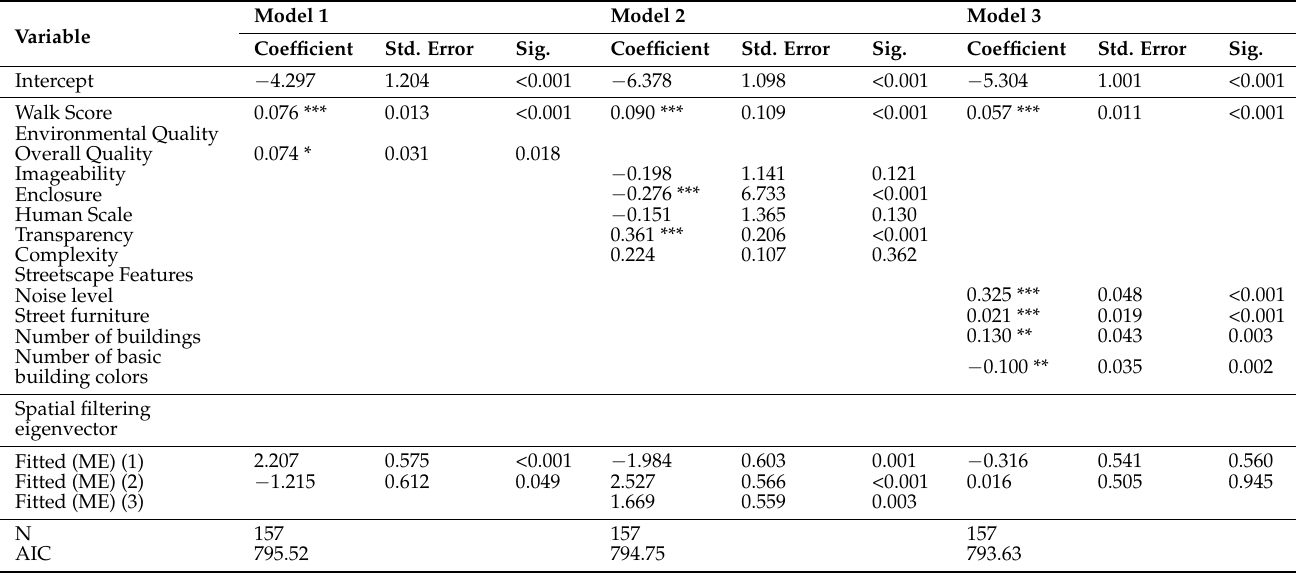
Table 7. Regression Model of Pedestrian